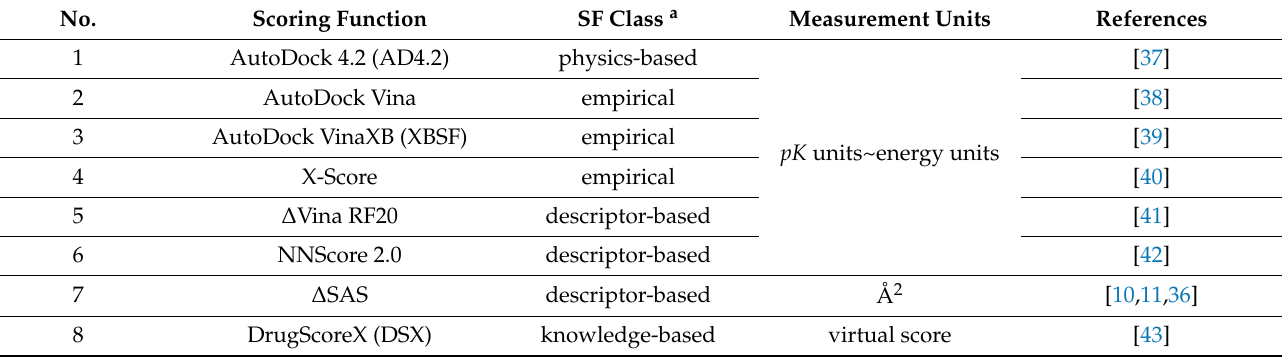
Table 10. The selected scoring